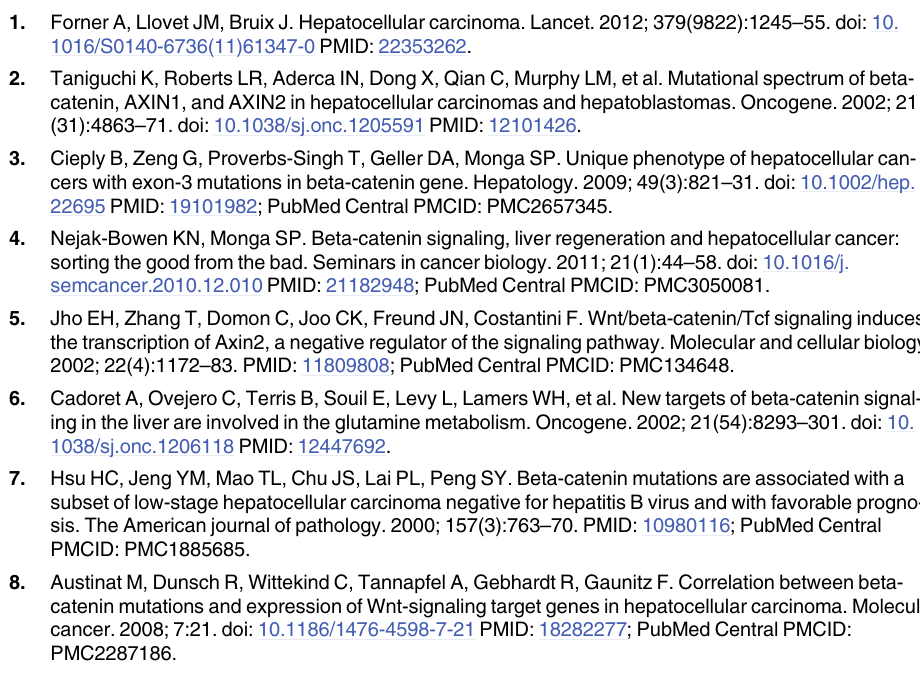
S1 Fig. All CTNNB1 mutations in exon3. S1 Table. Somatic mutations of β -Catenin in HCCs. S2 Table. β -Catenin mutation and clinicopathological characteristics. S3 Table. Patient characteristics with β -Catenin nuclear translocation in